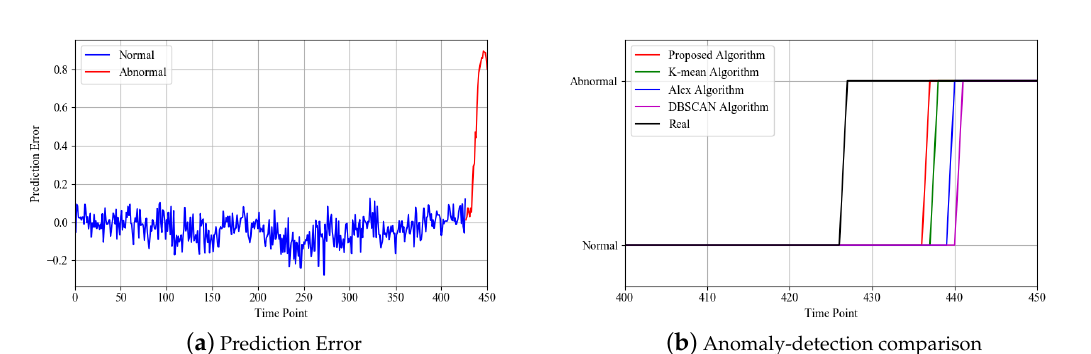
Figure 10. Anomaly detection